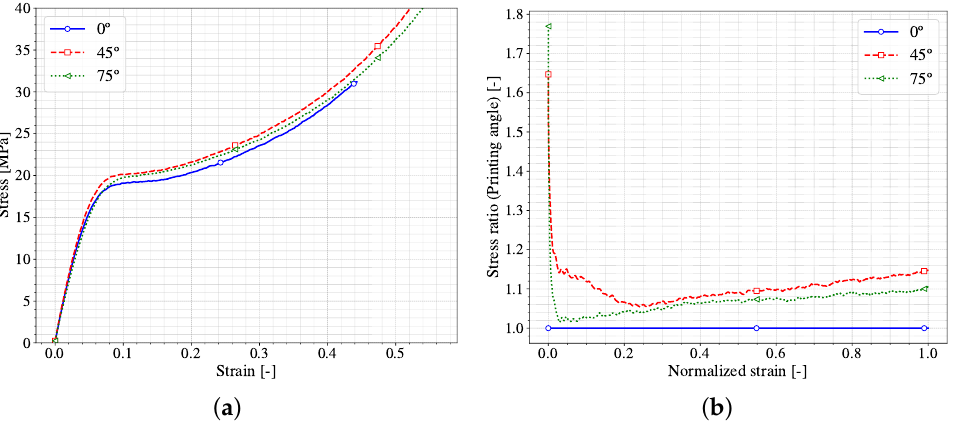
Figure 9. Printing angle influence in SLA process for quasistatic tensile tests. ( a ) σ vs. ε ; ( b ) Ratio of